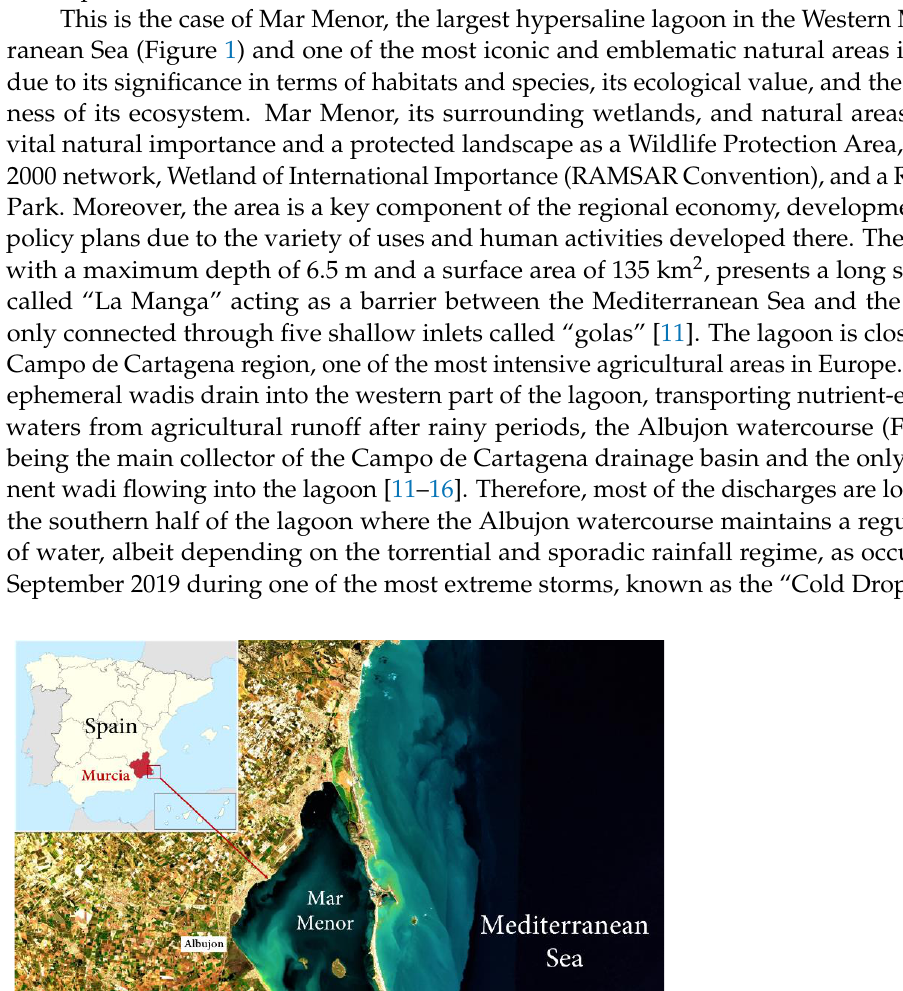
Figure 2. Land cover classification for the Mar Menor lagoon and its surroundings according to Corine Land Cover datasets (https://centrodedescargas.cnig.es/CentroDescargas/; accessed on 1 January 2022) for 1990 and 2018. The effects of these massive contributions of nutrients in the lagoon ecosystem have been cushioned by its elements that, for decades, have acted as mechanisms of homeosta- sis and resilience, preventing an excess of nutrients from being available to opportunistic